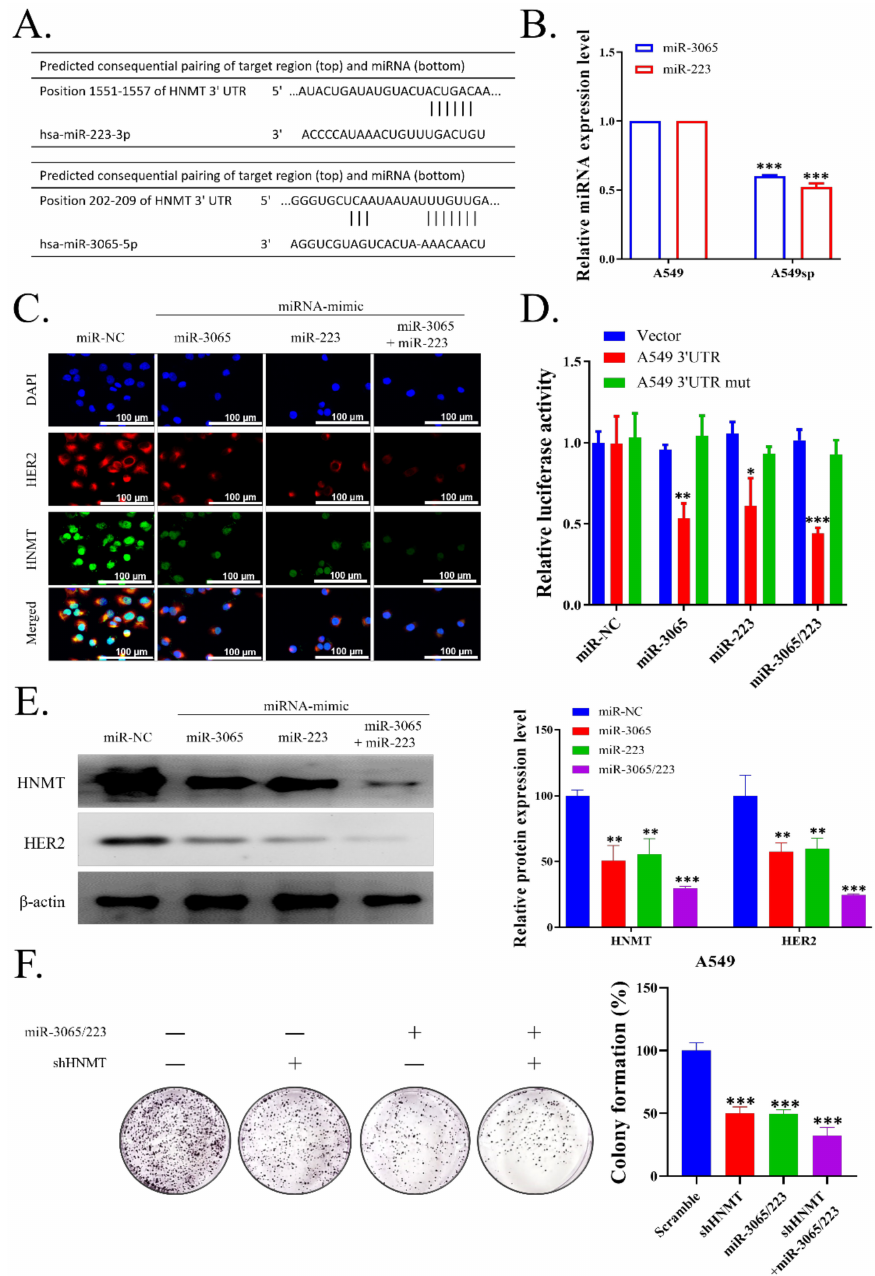
Figure 4. HNMT is one of the key target genes of miR-3065 and miR-223 in lung cancer. ( A ) Comple- mentary sites for miR-3065-5p and miR-223 in the 3 (cid:48) UTR region of HNMT according to TARGETSCAN (version 6.2). ( B ) miR-3065-5p and miR-223 expression in adherent versus sphere H441 cells. RNU 6-2 was used as control. Both qPCR results were normalized to adherent H441 value. ( C ) Immunofluorescence staining of HNMT and HER2 in H441 cells transfected with NC or miR-3065 and/or miR-223 inhibitor demonstrated differential localization. DAPI staining (blue) was used to label DNA in all cells. Scale bar = 100 µ m. ( D ) H441 cells were cotransfected with miR-3065, miR-223, or control mimic (miR-NC) and wild-type (WT) or mutated (mut) HNMT 3 (cid:48) UTR-directed luciferase reporter. Luciferase activity was measured using dual-luciferase reporter assays. ( E ) Western blotting of HNMT and HER2 differential protein expression in H441 cells transfected with NC or miR-3065 and/or miR-223 inhibitor. ( F ) H441 cells transfected with NC or miR-3065 and/or miR-223 mimics showing differential colony formation potential. Graph bars are mean ± SDs of three independent experiments. * p < 0.05, ** p < 0.01, *** p < 0.001. Scale bar: 100 µ